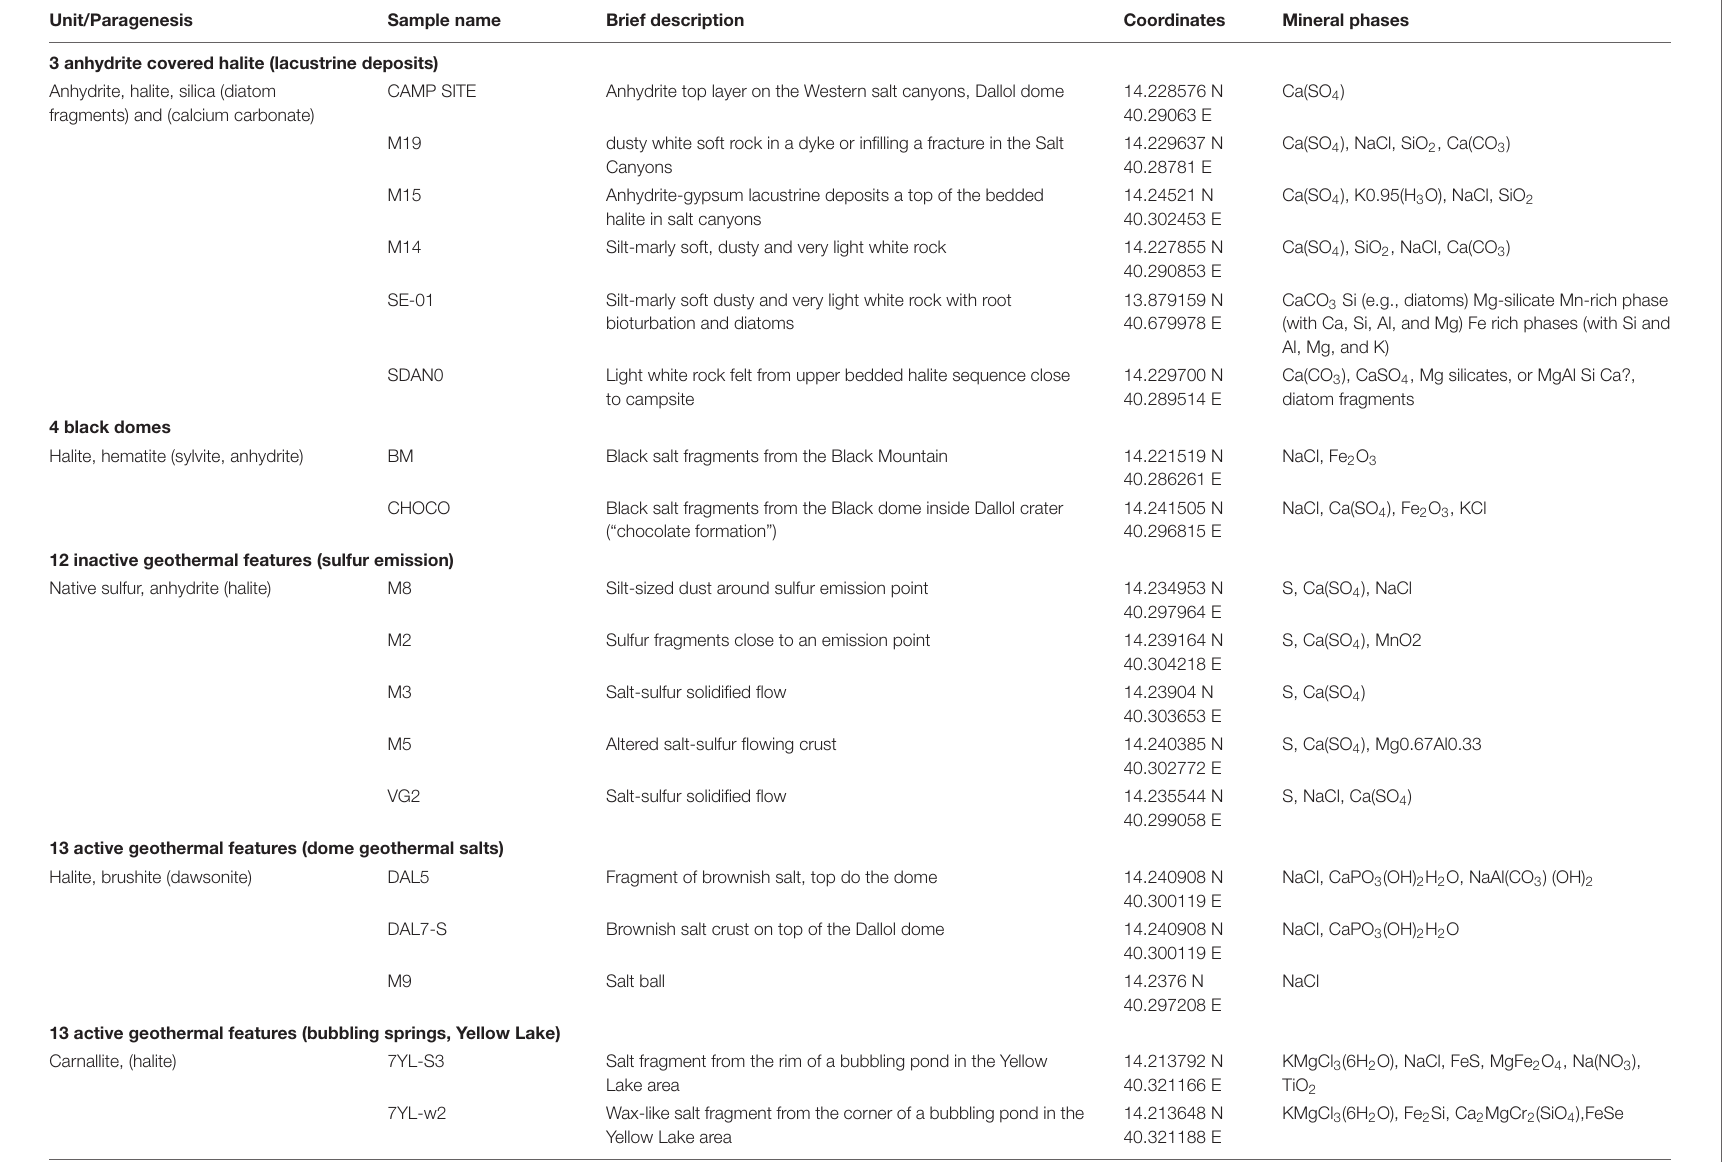
TABLE 1 | Identification of mineral phases in samples from the Dallol dome and